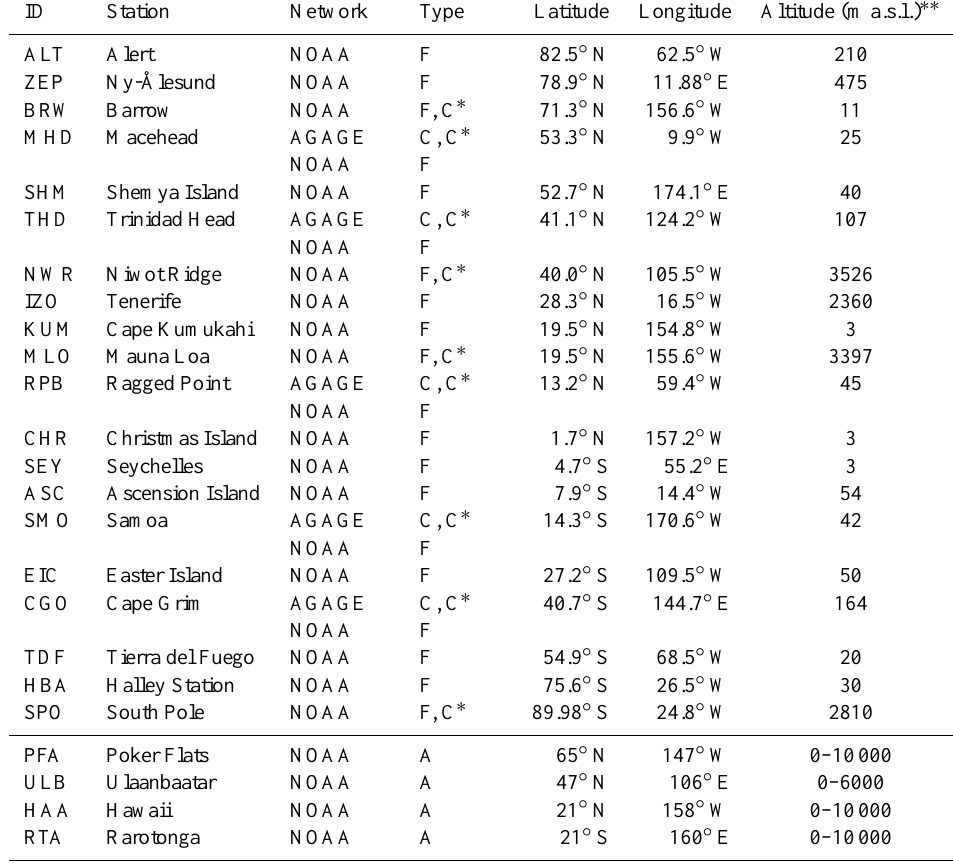
Table 4. Atmospheric sites used in the analysis.